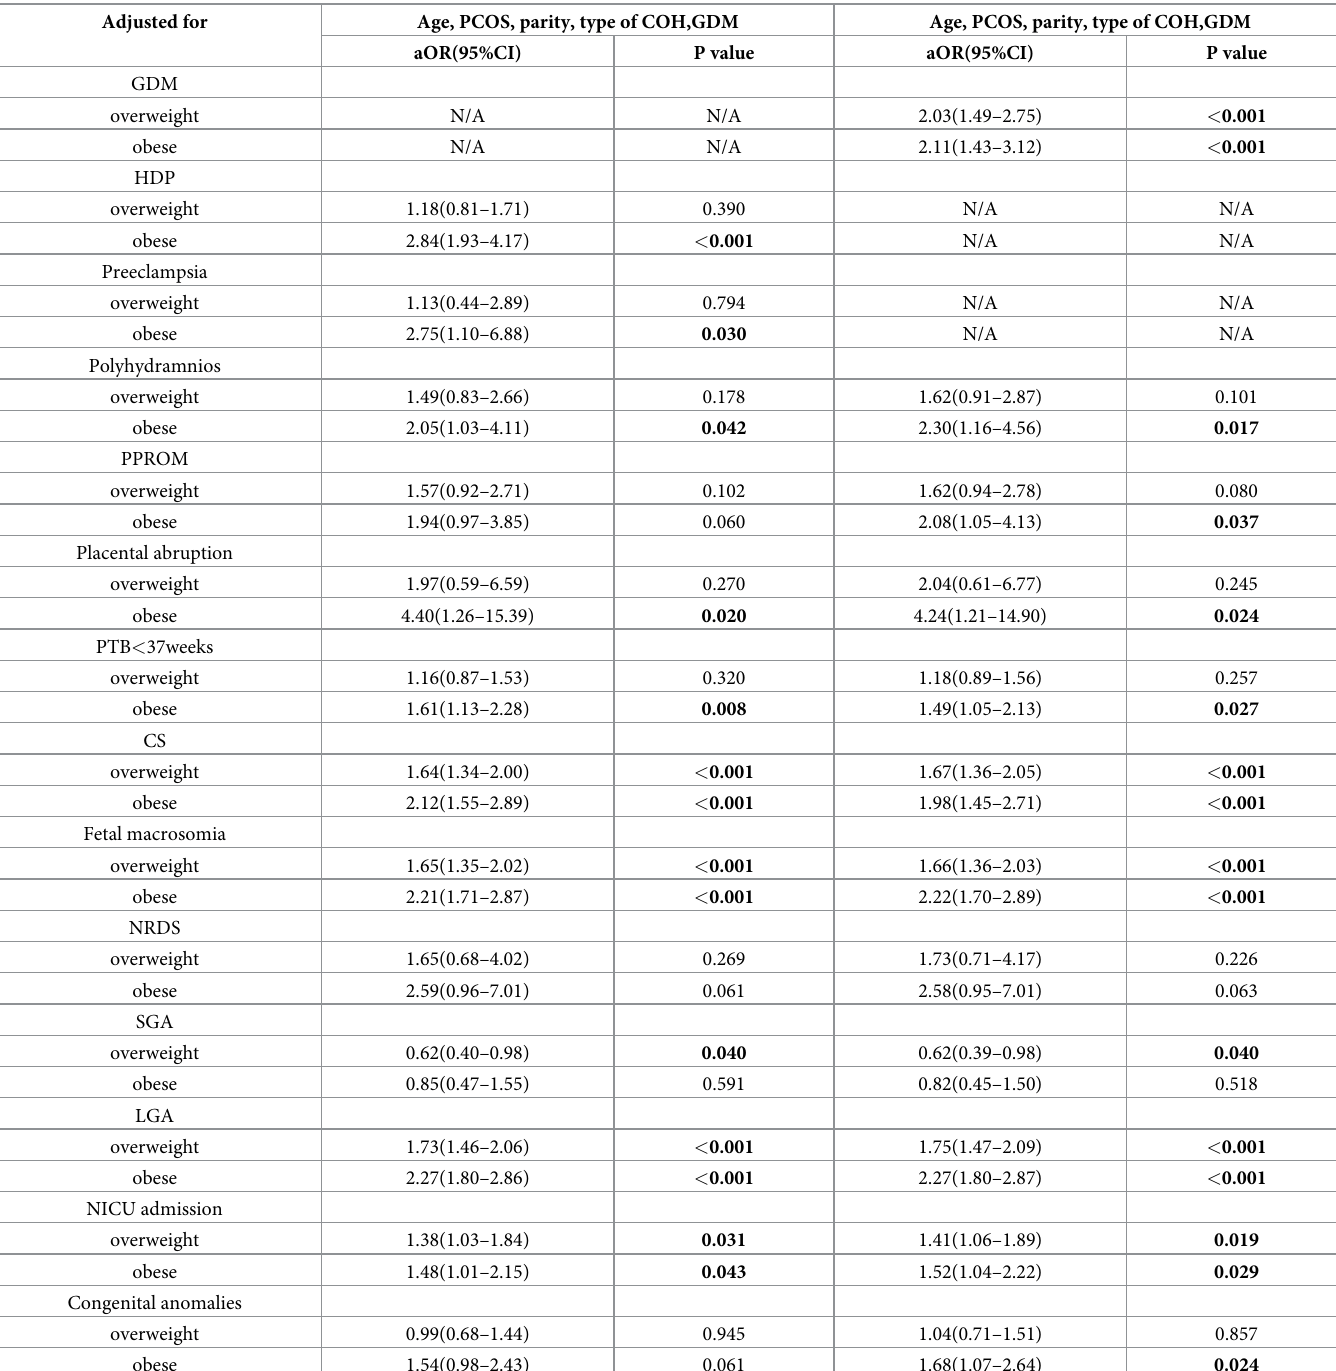
Table 4. Perinatal outcomes by BMI category when GDM/HDOP was adjusted (in addition to age, PCOS, parity and type of COH). Adjusted